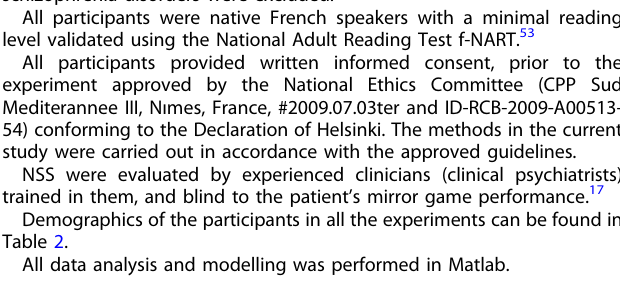
Table 2. All data analysis and modelling was performed in